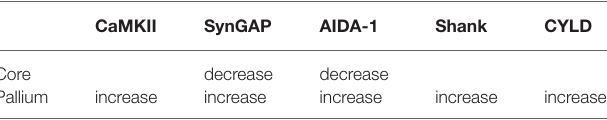
TABLE 1 | Redistribution of postsynaptic density (PSD) components during